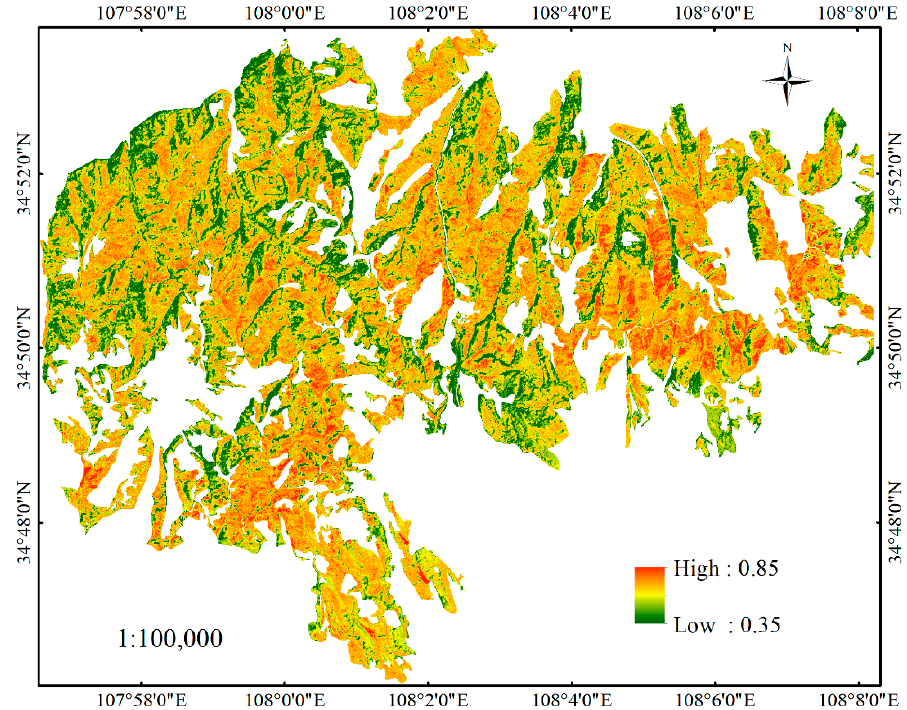
Figure 6. Predicted CC map of the black locust plantations based on Model 3 using QuickBird imagery.